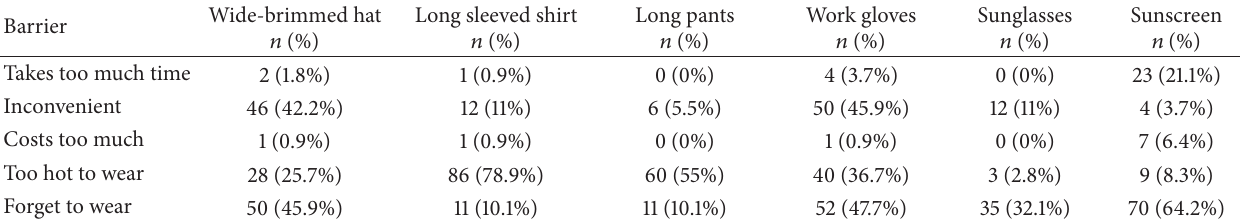
Table 2: Frequencies and percentages of barriers to continuous practicing of sun protection behavior. Barrier